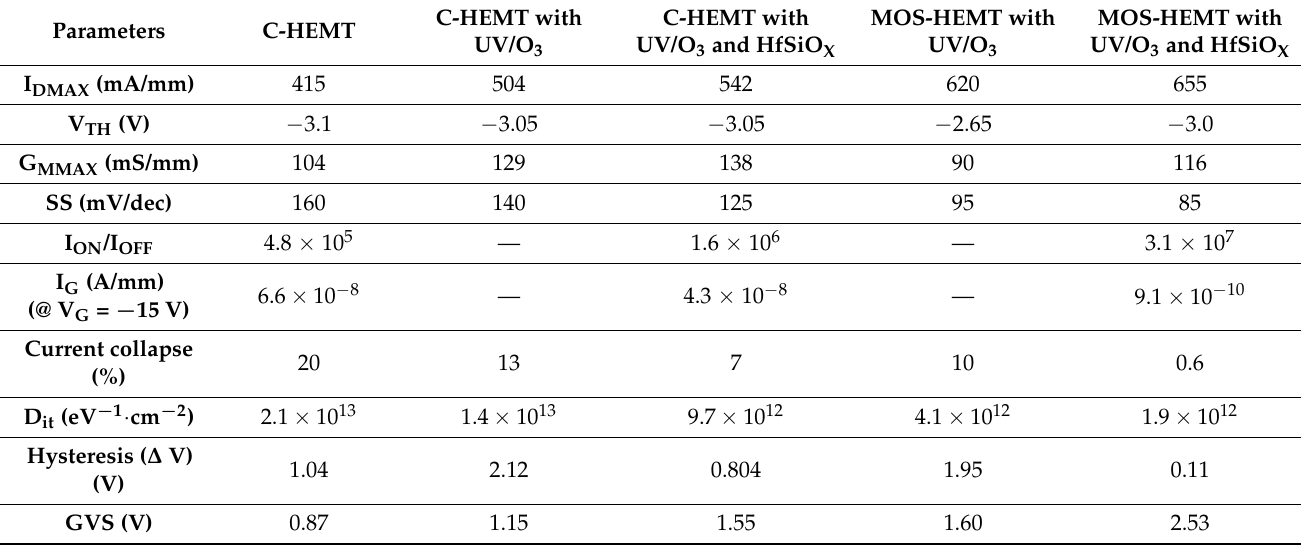
Figure 7. Comparison of C-V characteristics of C-HEMT ( a ) with and without UV/O 3 treatment, and ( b ) MOS-HEMT with and without HfSiO X passivation. ( c ) Flicker noise characteristics of MOS-HEMT with and without HfSiO X passivation, and C-HEMT without any treatment. Table 1. Comparison MOS-HEMT and C-HEMT with different